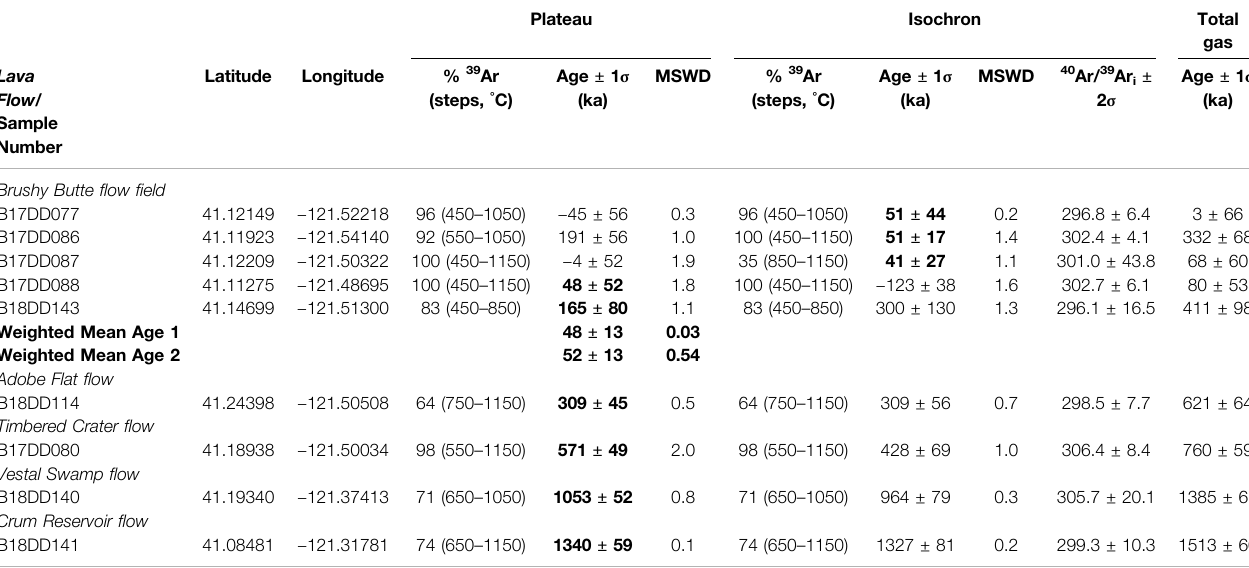
TABLE 3 | 40 Ar/ 39 Ar ages of the Brushy Butte fl ow fi eld and surrounding tholeiitic